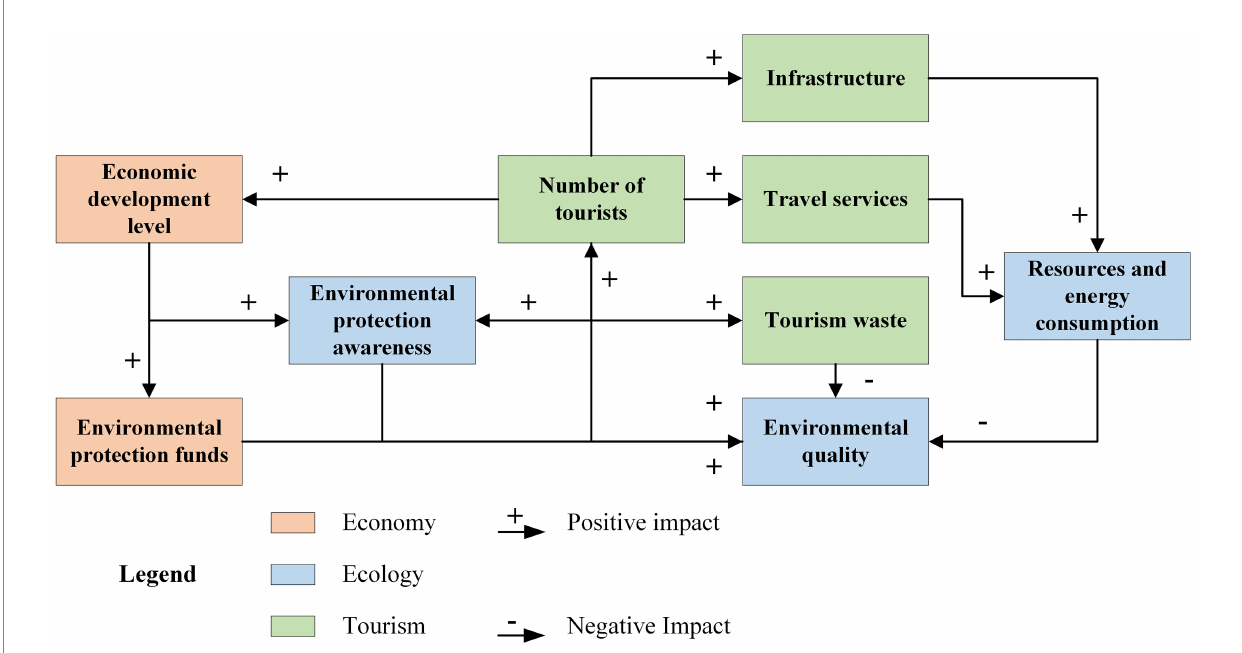
FIGURE 1 The action process of tourism economic elements on ecological environment